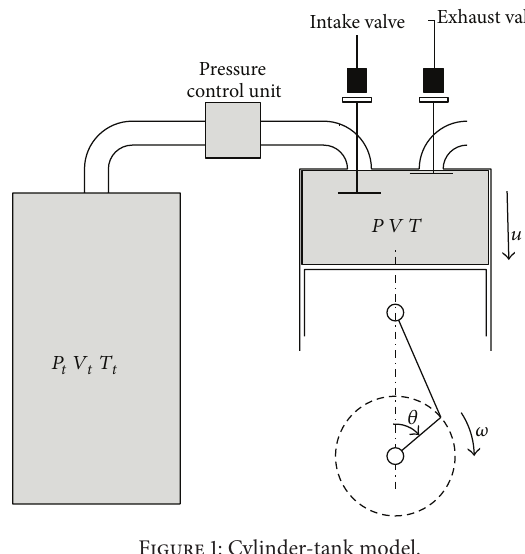
Figure 1: Cylinder-tank model.